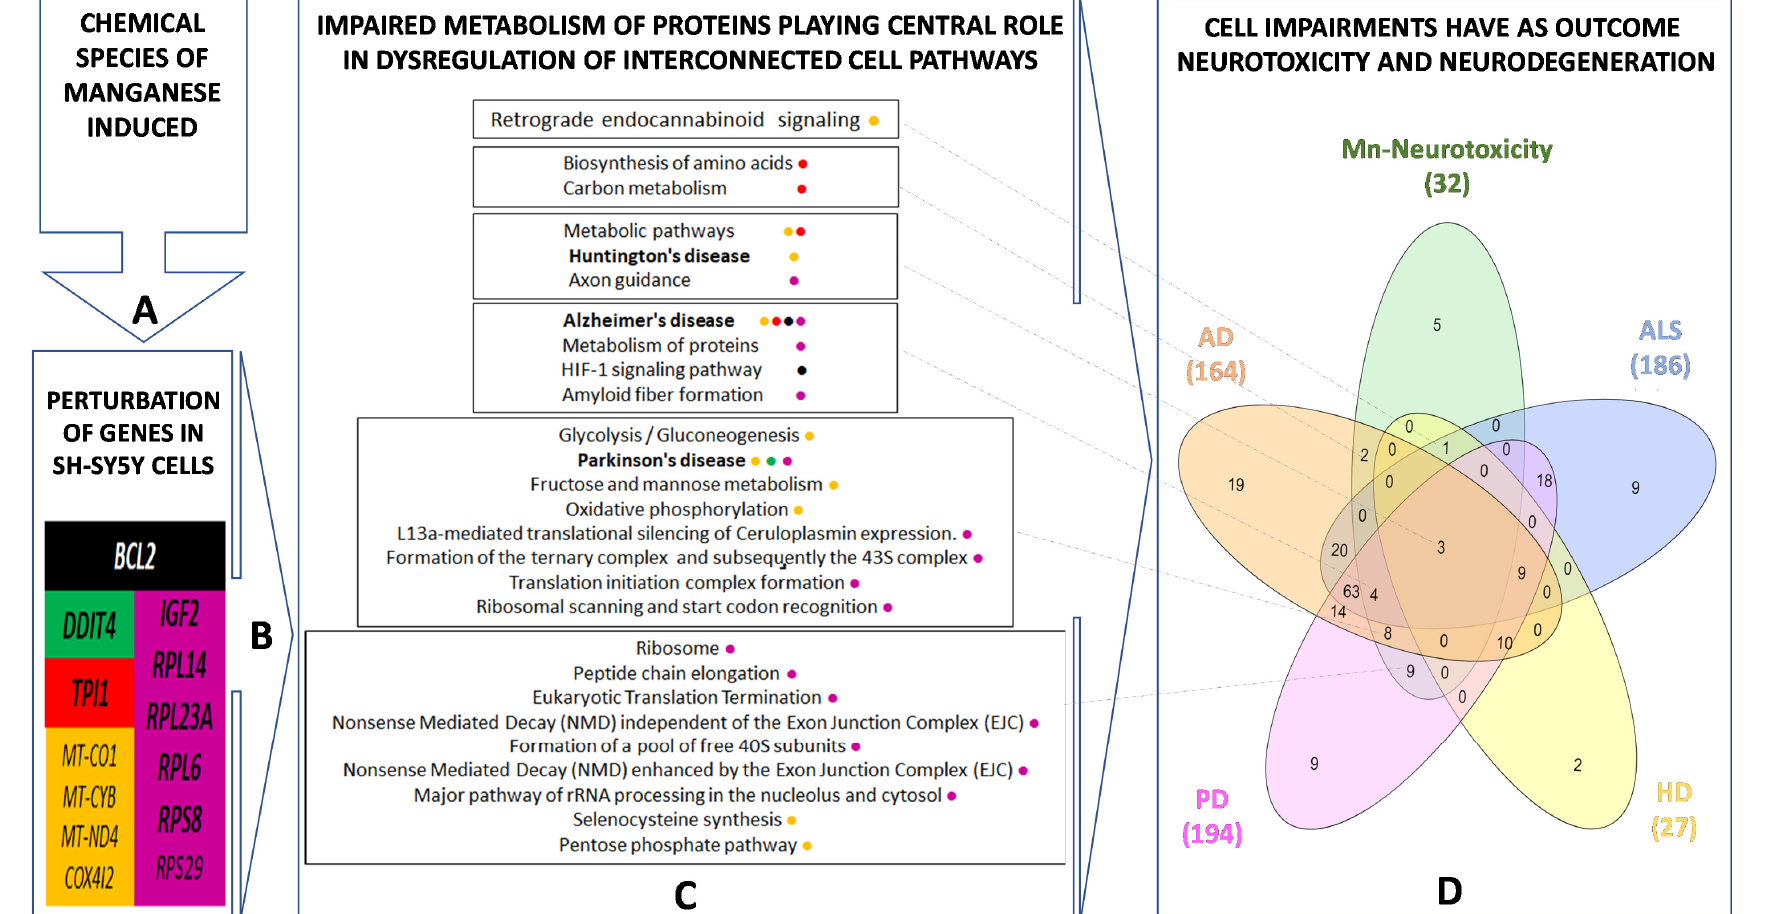
Figure 5. Comparative toxicogenomics analysis for Mn-induced cytotoxicity in SH-SY5Y . Exposure of SH-SYSY cells to different chemical species of Mn ( A ) results in disruption of genes shown in ( B ). This can lead to impairment of protein metabolism that plays a central role in the dysregulation of several pathways such as cell signaling; cell metabolism, including energy pathway; Alzheimer’s Disease (AD); Huntington’s Disease (HD) and Parkinson’s Disease (PD) ( C ). Overlapping pathways among Mn-induced neurotoxicity and Amyotrophic Lateral Sclerosis (ALS), AD, HD, and PD is shown in ( D ).